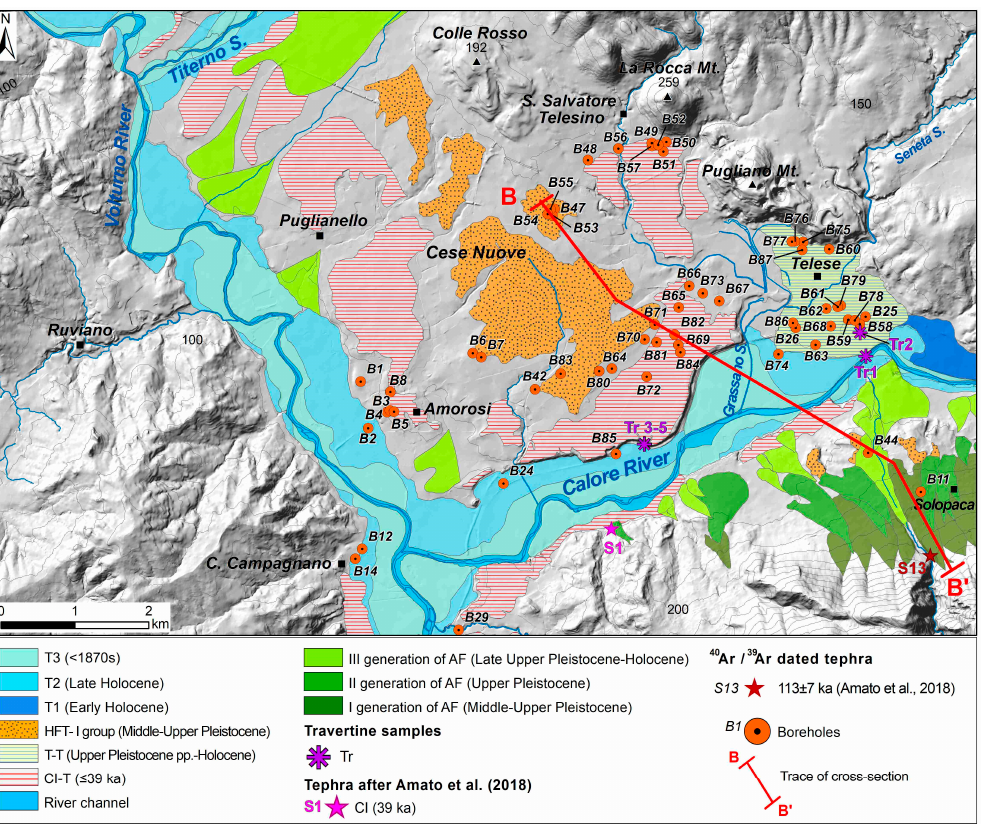
Figure 9. Geomorphological sketch of sector B.